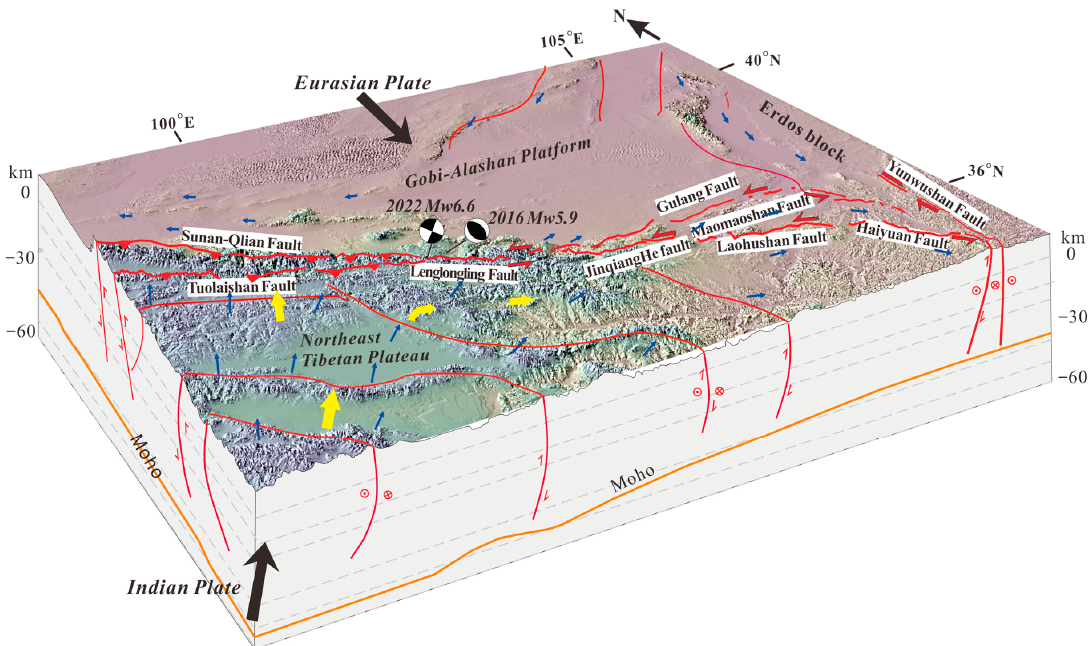
Figure 2. Comprehensive seismotectonic model of the LLLF zone and surrounding areas. The thick yellow arrows indicate the directions of plate movements. The narrow blue arrows indicate the GPS velocity field with the Gobi-Alashan block referenced from [13]. Profiles of the Haiyuan and Yunwushan fault zones are referenced from [15]. Profiles of the Tuolaishan and Qilian-Sunan fault zones are referenced from [16,17]. The Moho depth is referenced from [18,19].